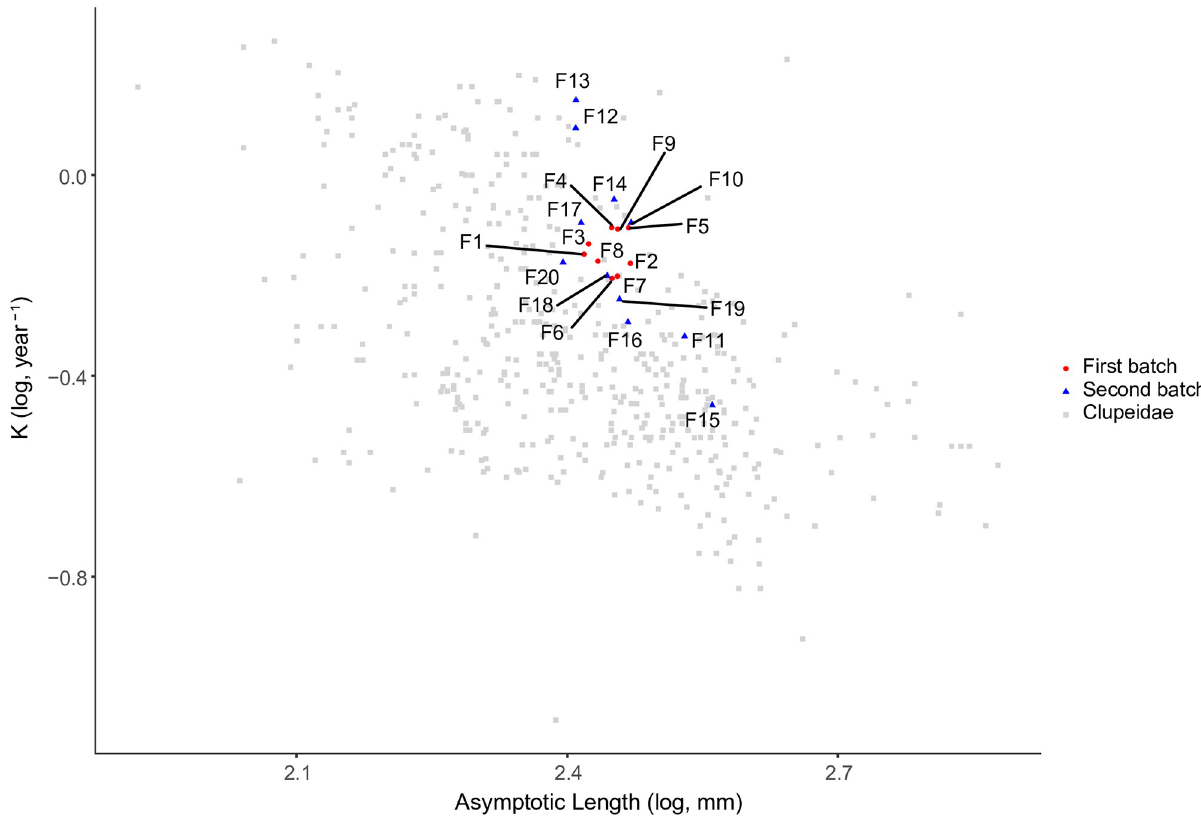
Fig 2. Auximetric plot (K versus TL 1 ) for Downs herring ( Clupea harengus ) females (first batch in red, second batch in blue) and Clupeidae FishBase data (in grey). Both axes are log 10 transformed.